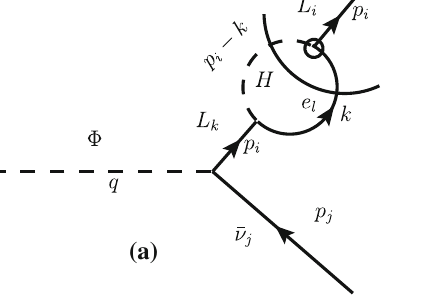
Fig. 4 Thermal TO cuts (circlings) for producing a non-vanishing CP asymmetry in ¯ ν (cid:11) → L i j decay. The external thermal indices are fixed to + , while the internal ones are summed over